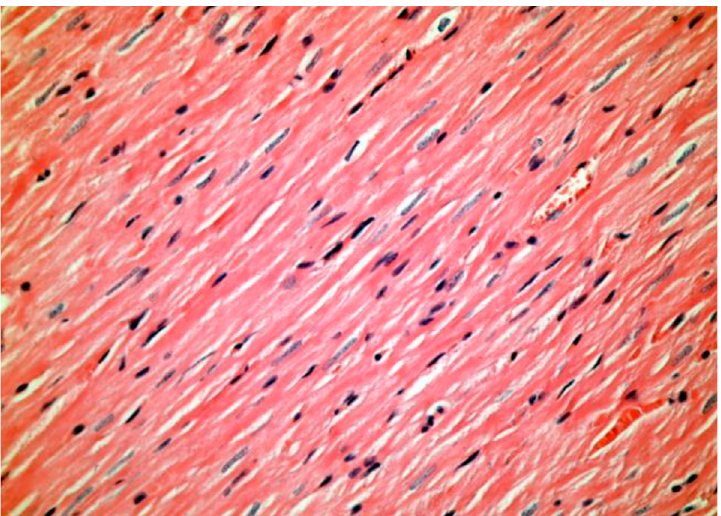
Fig. 1 - In the cilostazol group, natural myocardial tissue is observed (hematoxylin-eosin ×